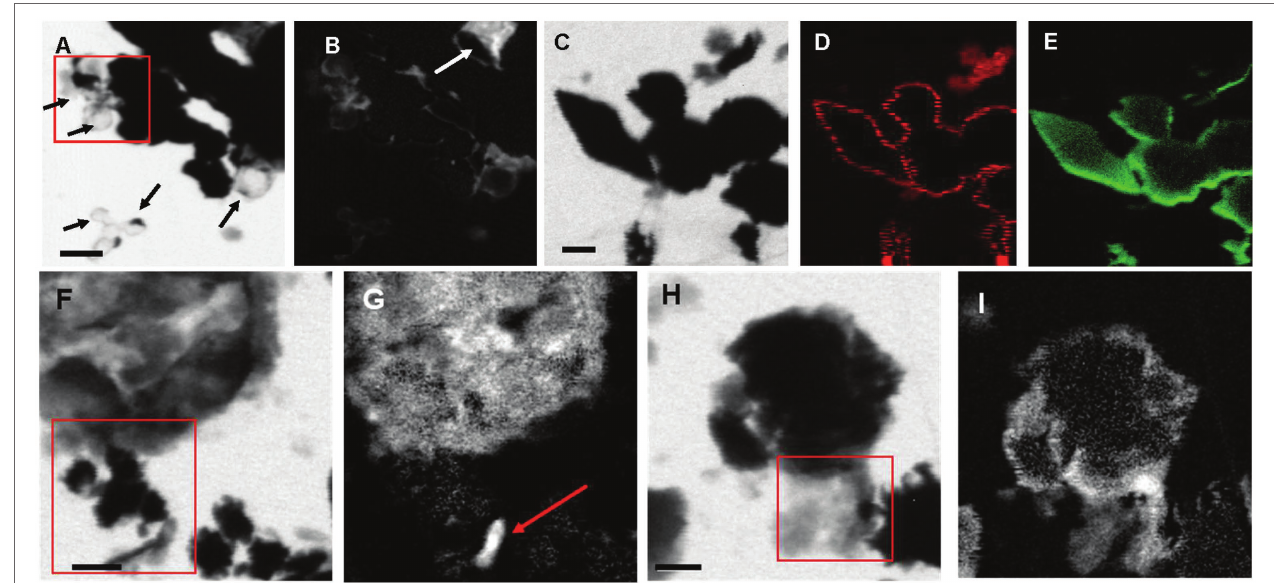
FIGURE 7 | STXM images and maps of S ulfurovum -dominated streamer biofilm. (A–B) Sample PC1647. (A) image collected at 288.1 eV. Black areas are S(0) particles. The empty spherical envelopes of vaporized S(0) globules are visible (black arrows). (B) Corresponding carbon map. The white arrow shows the carbon enveloped around a partially vaporized S(0) particle (a chain of S(0) bipyramids). (C–I) Sample PC1718. (C) Image collected at 288.2 eV. (D) Carbon map. (E) Sulfur map. (F) Image collected at 300 eV. (G) Carbon map. The arrow points to a rod-shaped microbial cell. (H–I) Image collected at 300 eV. (I) Carbon map. The boxes in (A), (F), and (H) and the arrow in (B) indicate where XANES analyses shown in Figure 8 were performed. Scale bars: 1 μ